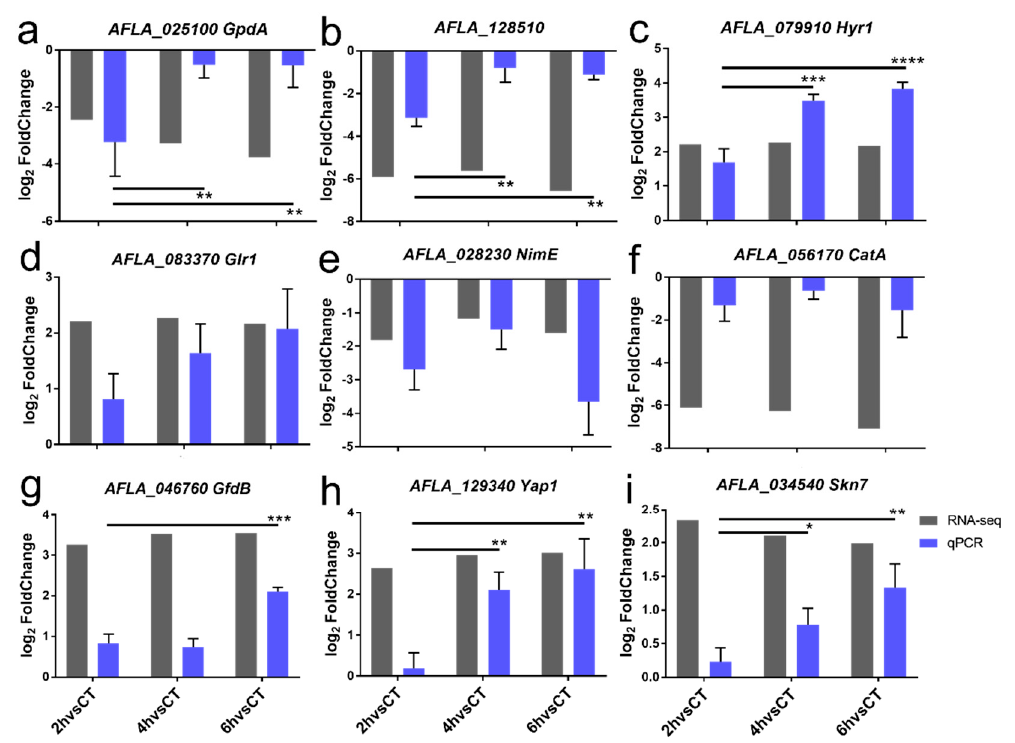
Figure 8. Validation of relative expression levels of critical differentially expressed genes in transcriptome data by RT-qPCR. ( a ) Glycolysis pathway, ( b ) 6-phosphogluconate dehydrogenase encoded by AFLA_128510 of PPP pathway, ( c , d ) GSH metabolism pathway, ( e – g ) MAPK pathway, and ( h , i ) two transcription factors. Relative expression level of DEGs was showed using an index of log 2 FoldChange, which was calculated as a ratio of a gene expression level in PAE treatment and control group. Data are means ± standard deviation of three replicates. * p < 0.05; ** p < 0.01; *** p < 0.001; **** p < 0.0001.